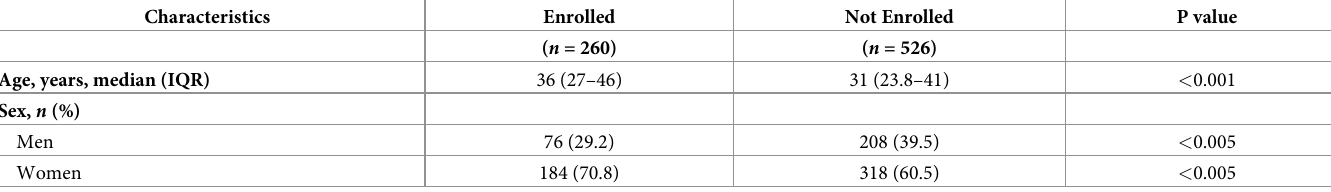
Table 2. Age and sex of 786 individuals assessed for eligibility in the ZIKABRA study.